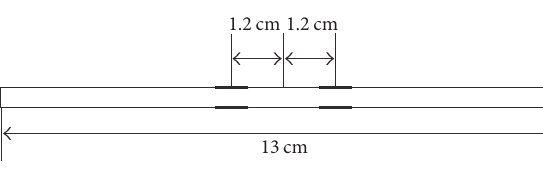
Figure 6: The strain location on the dowel bar.